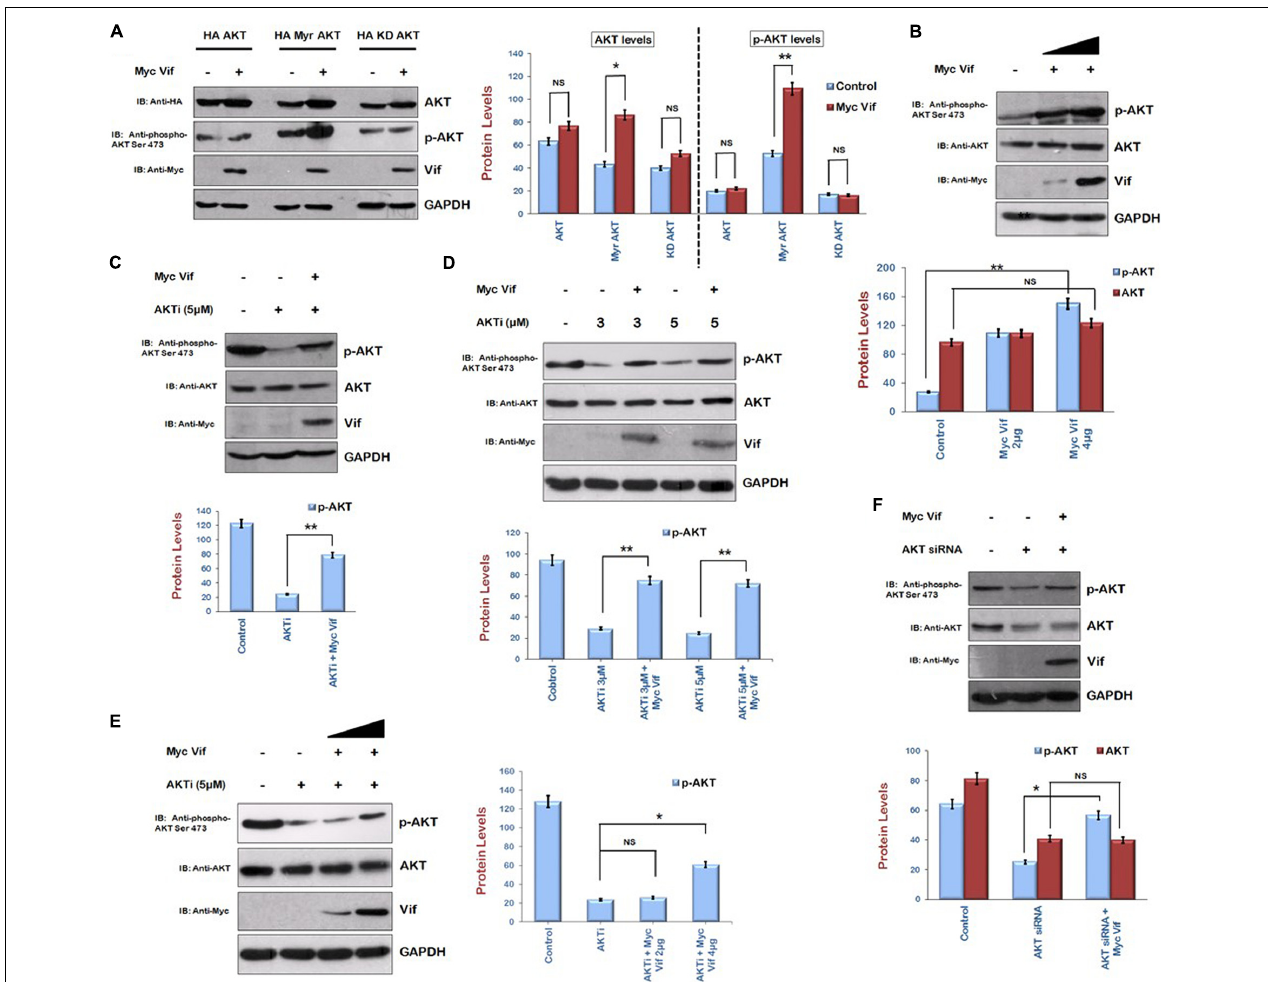
FIGURE 1 | Human immunodeficiency virus type 1 Vif induces phosphorylation of AKT at Ser473. (A) HEK-293T cells were cotransfected with HA AKT, HA Myr-AKT, HA KD-AKT, and Myc Vif as shown for 24 h. Cell lysates were analyzed by Western blotting with anti-HA, anti–phospho-AKT Ser473, anti-Myc, and anti-GAPDH antibodies. (B) HEK-293T cells were transfected with increasing amounts of Myc Vif expression plasmid for 24 h. Cell lysates were analyzed by Western blotting with anti-AKT, anti-Myc, anti–phospho-AKT Ser473, and anti-GAPDH antibodies. (C) HEK-293T cells were transfected with Myc Vif expression plasmid and treated with AKTi (5 µ M) as indicated for 24 h. Cell lysates were analyzed by Western blotting with anti-AKT, anti-Myc, anti–phospho-AKT Ser473, and anti-GAPDH antibodies. (D) HEK-293T cells were transfected with Myc Vif and treated with increasing dose of AKTi (3 and 5 µ M) for 24 h. Cell lysates were analyzed by Western